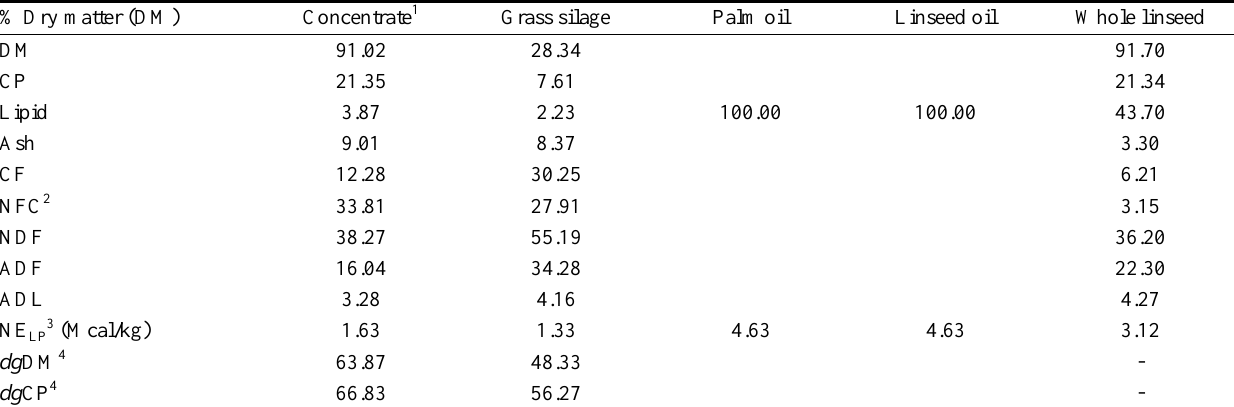
Table 1. Chemical composition of feed used in the experiment % Dry matter